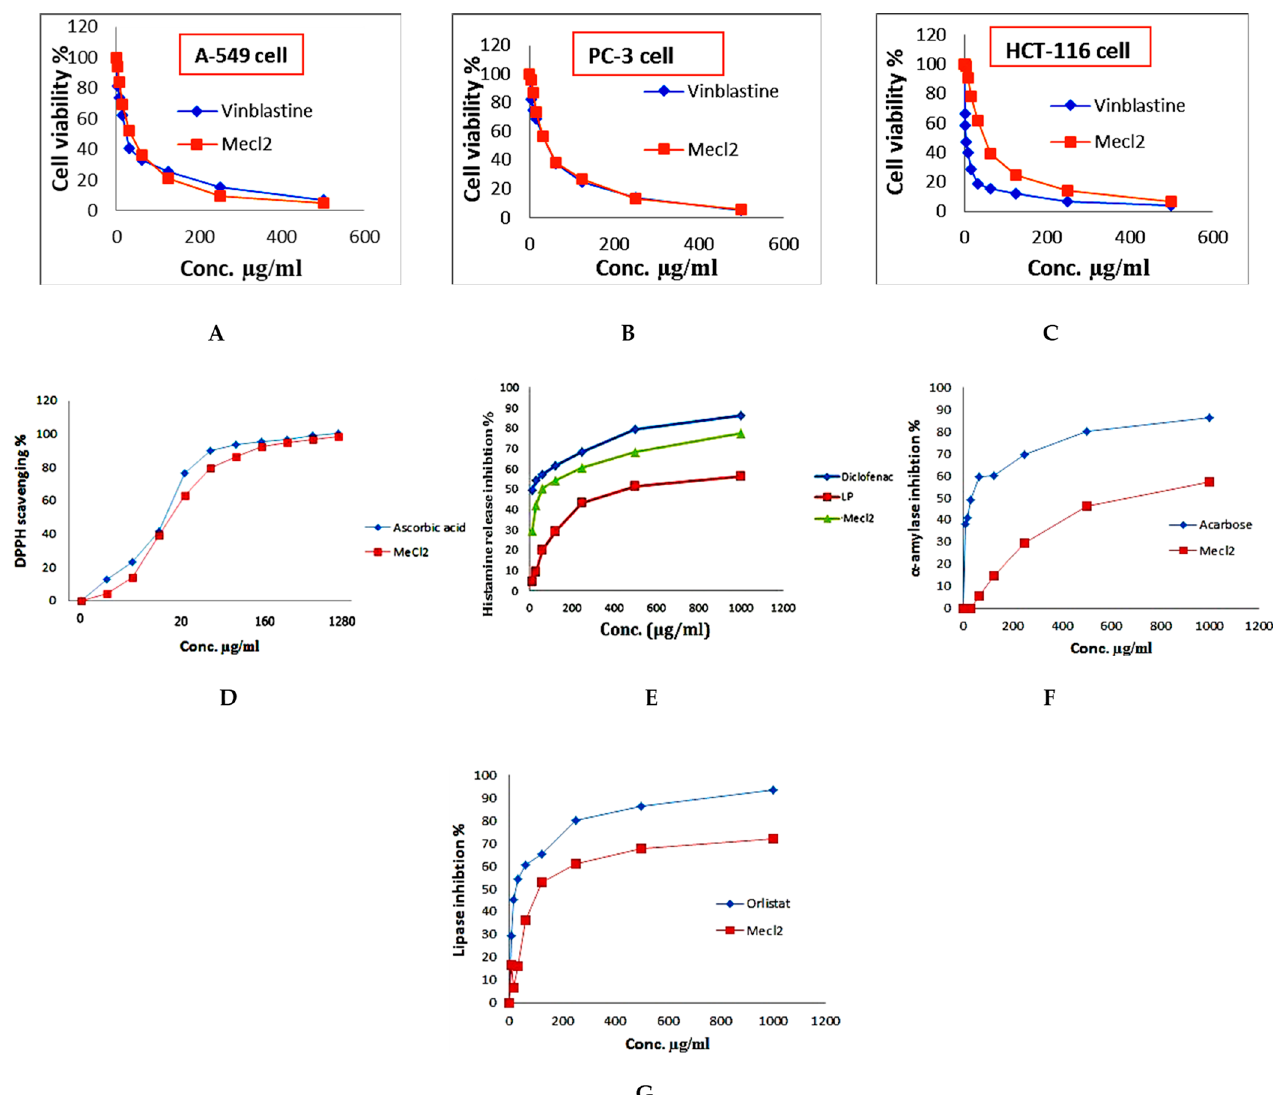
Figure 7. Biological actions of non-polar fractions of S. hispanica L. aerial parts. ( A – C ) cytotoxic activity, ( D ) antioxidant activity, ( E ) anti-inflammatory activity, ( F ) antidiabetic activity, ( G ) antiobesity activity.